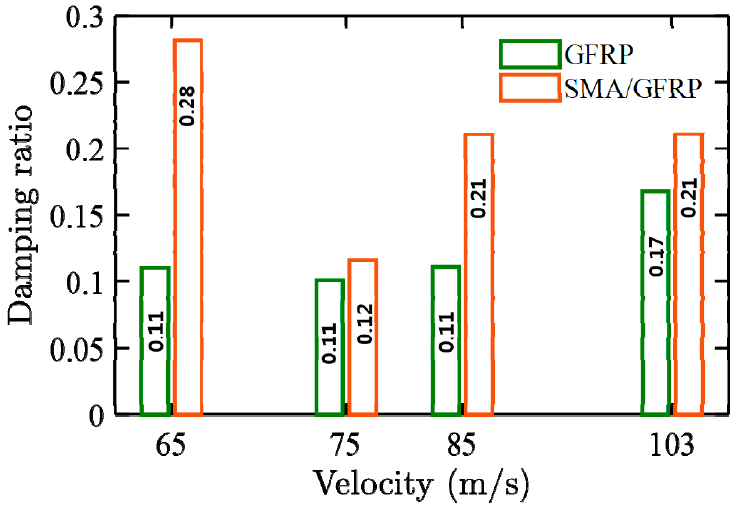
Figure 10. Damping ratio vs. velocity response for the GFRP and SMA/GFRP specimens at different impact velocities.